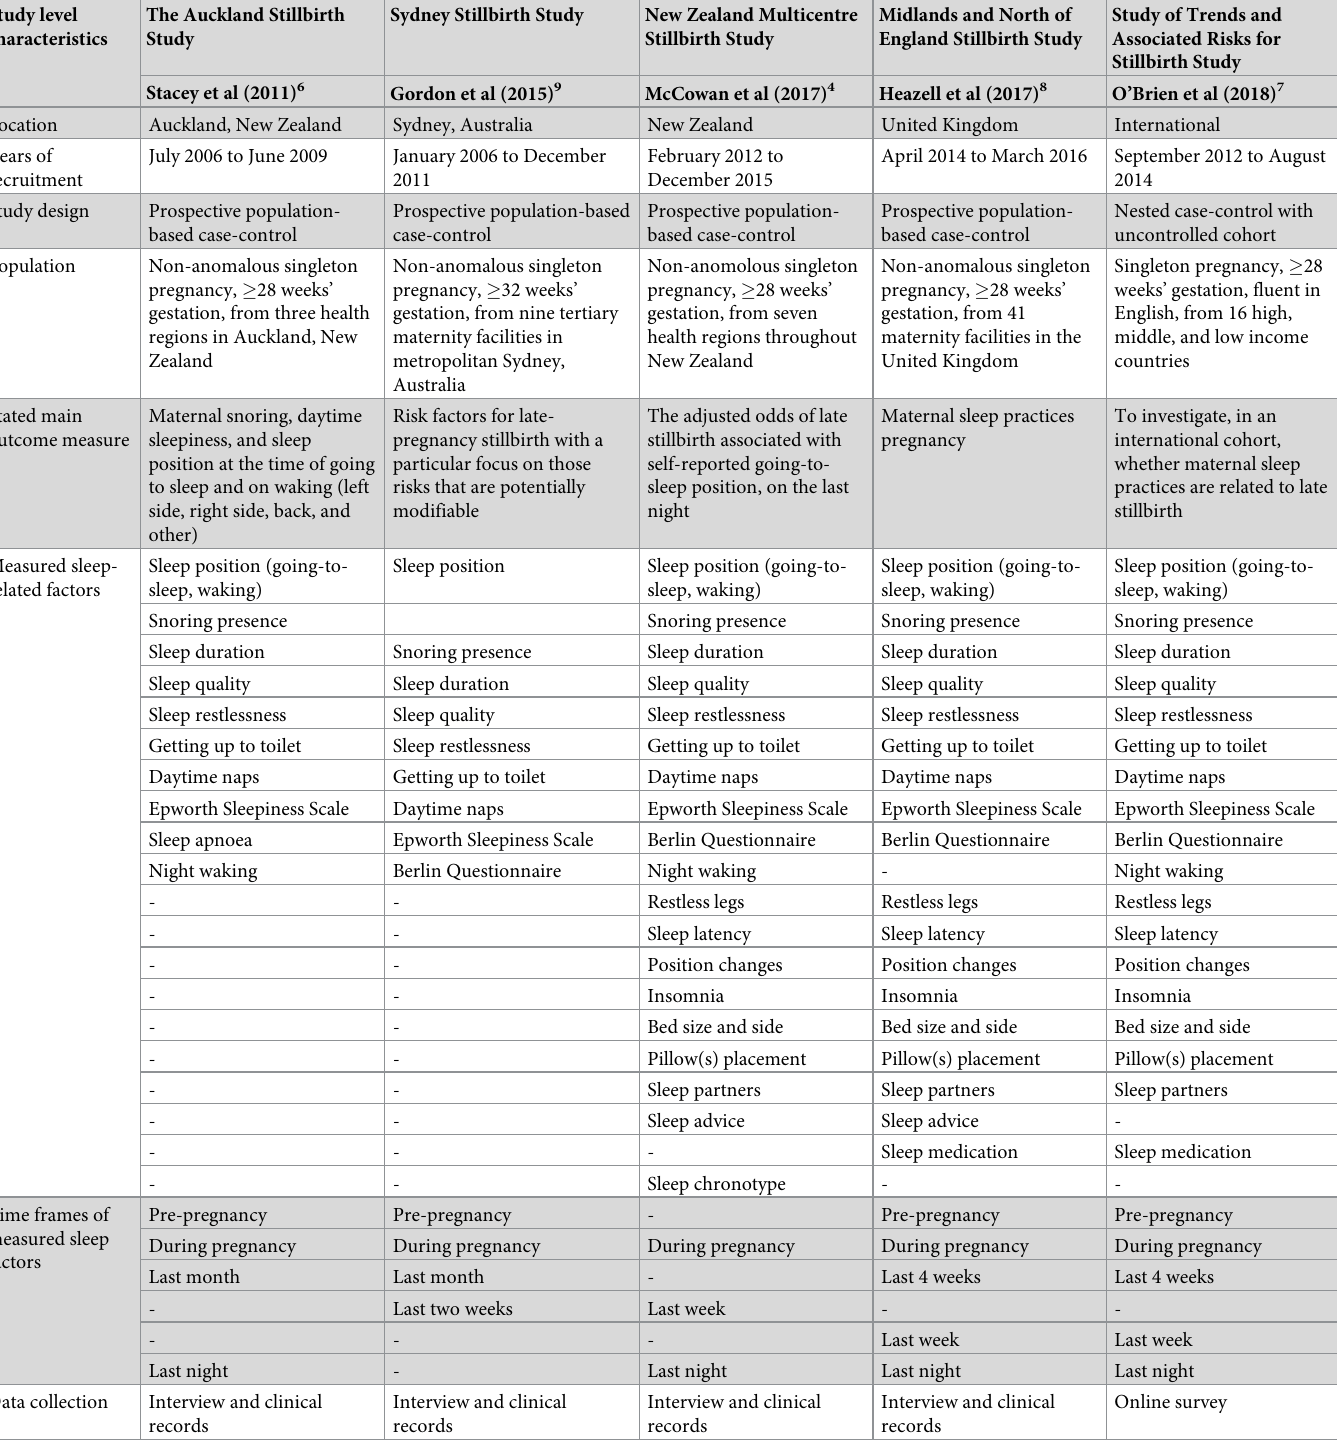
Table 1. Study level characteristics and measured sleep-related factors in participating studies. Study level